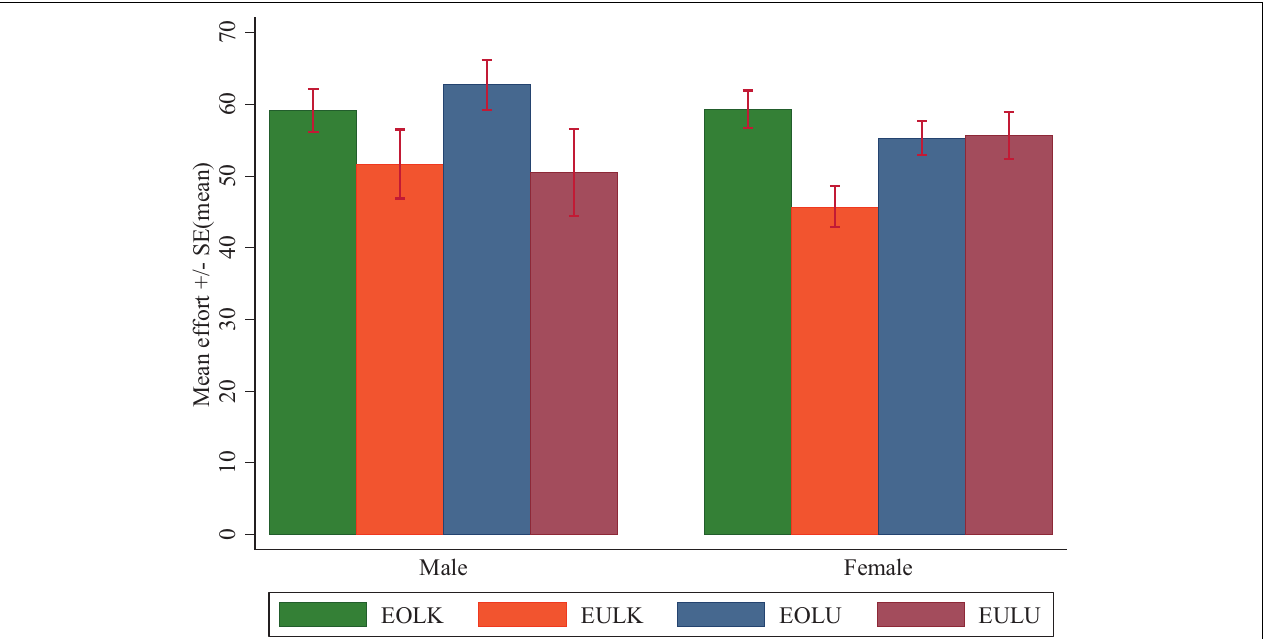
FIGURE 2 | Mean effort by treatment and gender. The figure presents mean effort in the four treatments for both male and female subjects (error bars indicate standard errors of the mean).